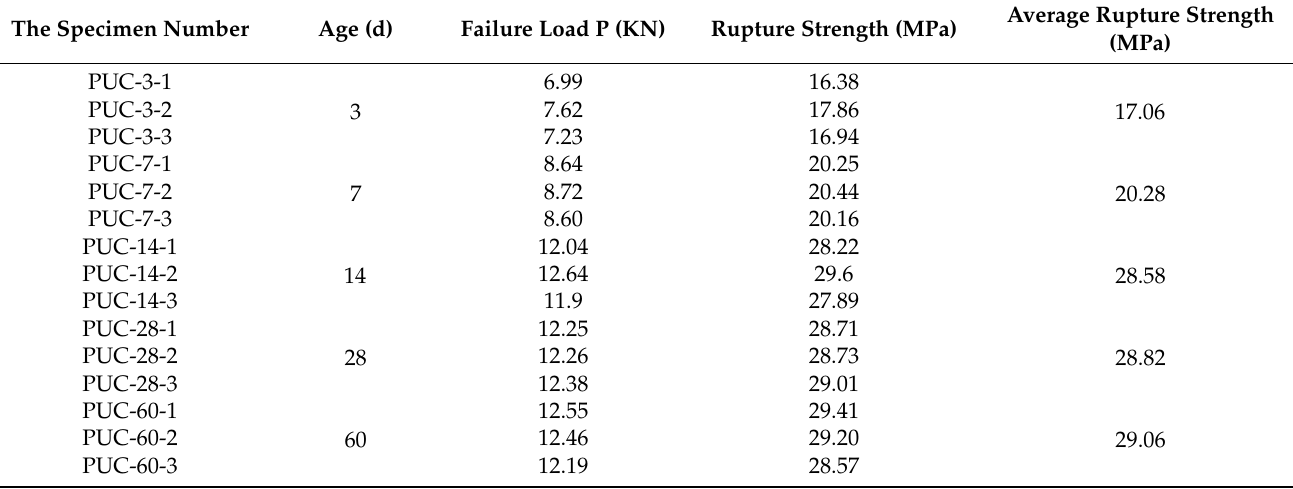
Table 7. Results of the flexural tensile strength test of prisms at standard